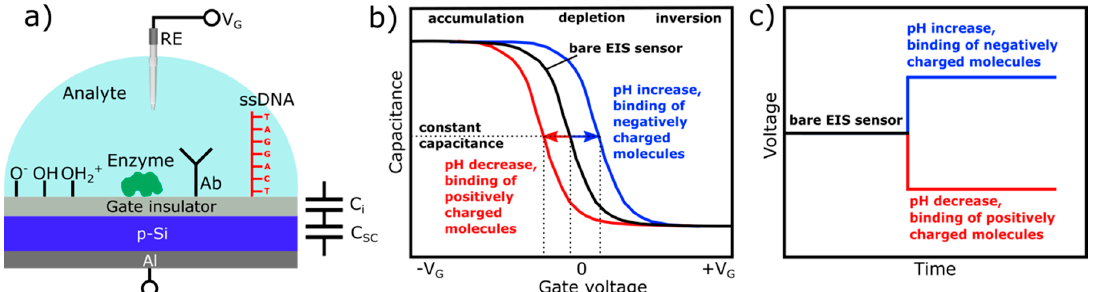
Figure 1. Layer structure of a capacitive electrolyte-insulator-semiconductor (EIS) sensor with different receptor functionalities (pH-/ion-sensing, enzyme, antibody, and DNA) and simplified electrical equivalent circuit ( a ); typical shape of high-frequency capacitance-voltage ( C–V ) curves ( b ); and ConCap response ( c ) of the bare and modified p-type EIS sensor. RE: reference electrode, V G : gate voltage, Ab: antibody, DNA: deoxyribonucleic acid, C i : gate-insulator capacitance, C SC : space-charge capacitance, ssDNA: single-stranded DNA.